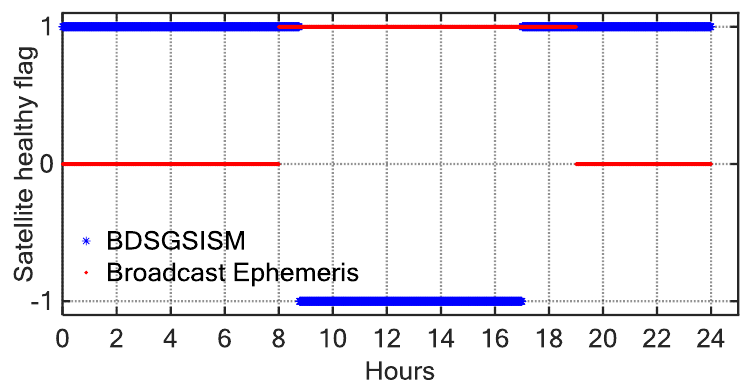
Figure 12. Satellite-health flag as a function of BDT, determined using two methods (blue *, BDSGSISM; red dots, broadcast ephemeris) on day 359 of 2015 for BDS satellite C10.